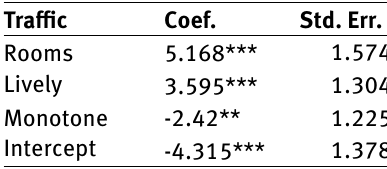
Table 3: Coefficients of the model for traffic noise.